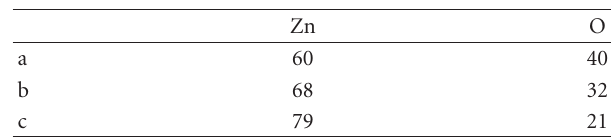
Table 2: Atomic percent composition estimated by energy disper- sive X-ray spectroscopy from Figure